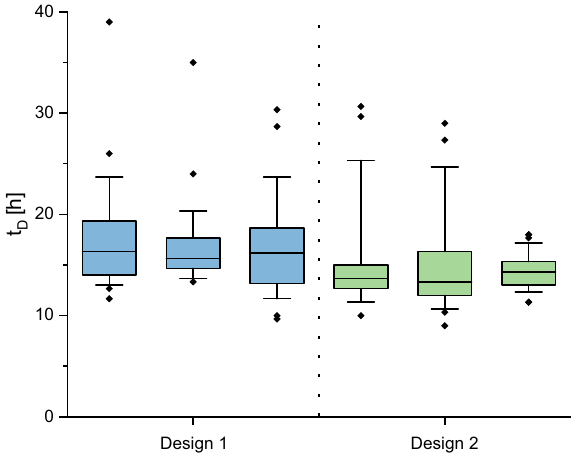
Figure 4. Comparison of single-cell division behavior between the two microfluidic cell retention concepts. Depicted are the single-cell doubling times t D of cells cultivated in chambers with Design 1 (n = 29, 25, 24) and Design 2 (n = 25, 27, 30). The colored segment marks the interquartile range from 25 to 75%, the horizontal lines show the median. The whiskers represent the 10% and 90% percentile and the tilted squares mark rare cellular events outside the predefined percentiles.